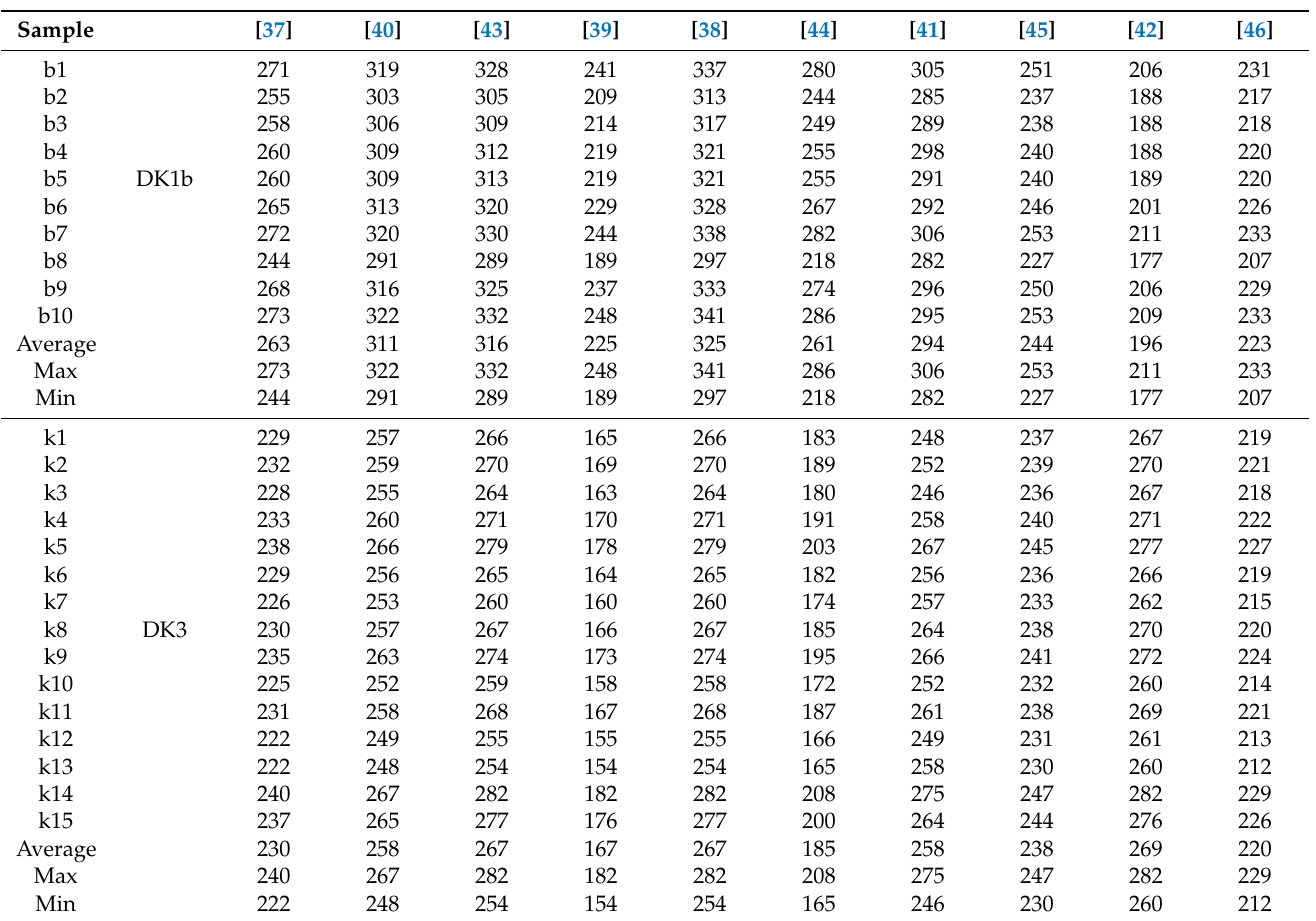
Table 5. Results of the thermometry calculations of chlorites in the diorite and microdiorite